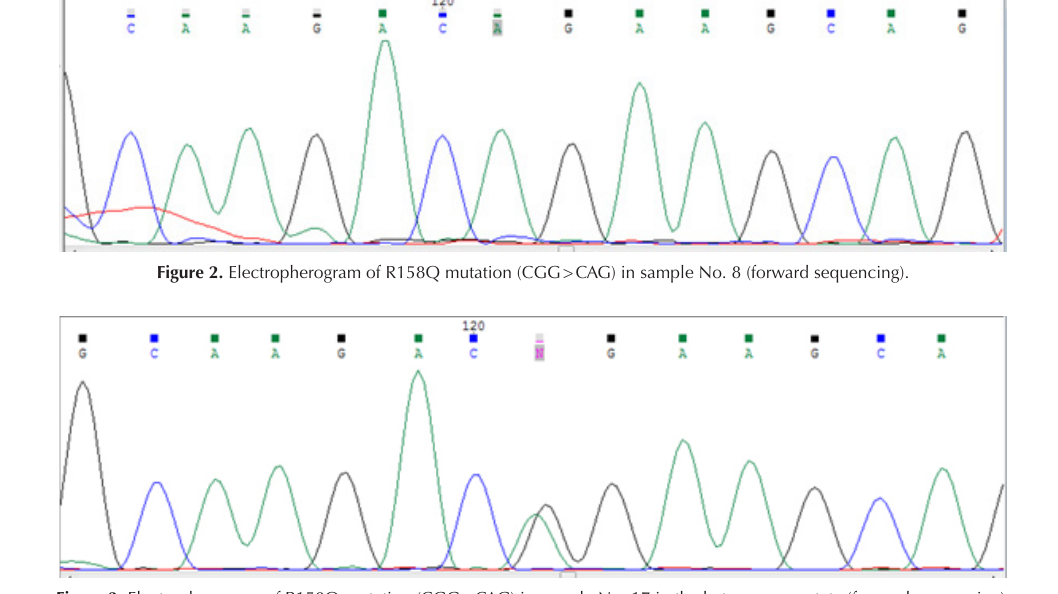
Figure 3. Electropherogram of R158Q mutation (CGG > CAG) in sample No. 17 in the heterozygous state (forward sequencing).